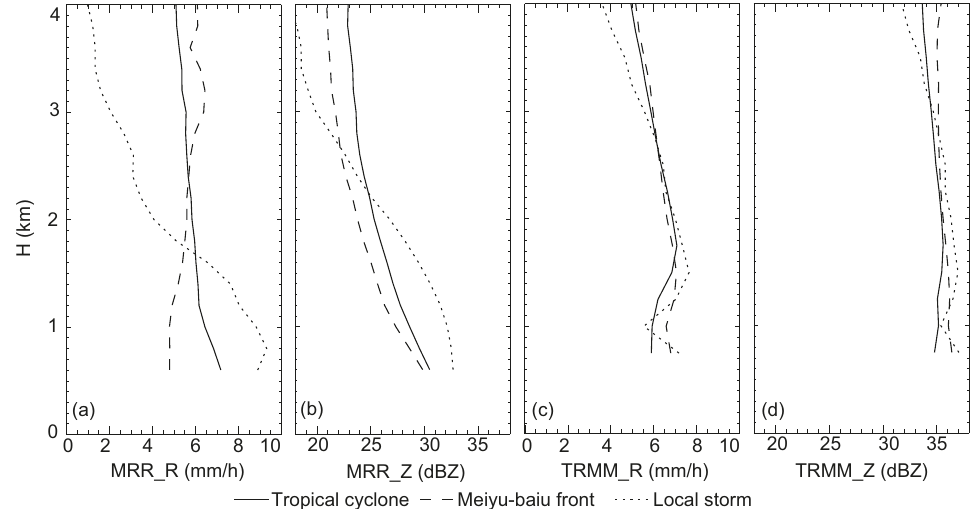
Figure 5. The vertical profiles of the mean rain parameters ( R and Z ) for the three rain types based on MRR data with a rain rate at 600 m of > 2 mm / h ( a , b ) and TRMM (2A25) PR data with a surface rain rate of > 2 mm / h for the area 33–37 ◦ N and 137–142 ◦ E ( c , d ). TRMM overpasses over Tokyo were used to calculate the tropical cyclones (20050726, 20060809, 20070714 and 20050825), the meiyu-baiu